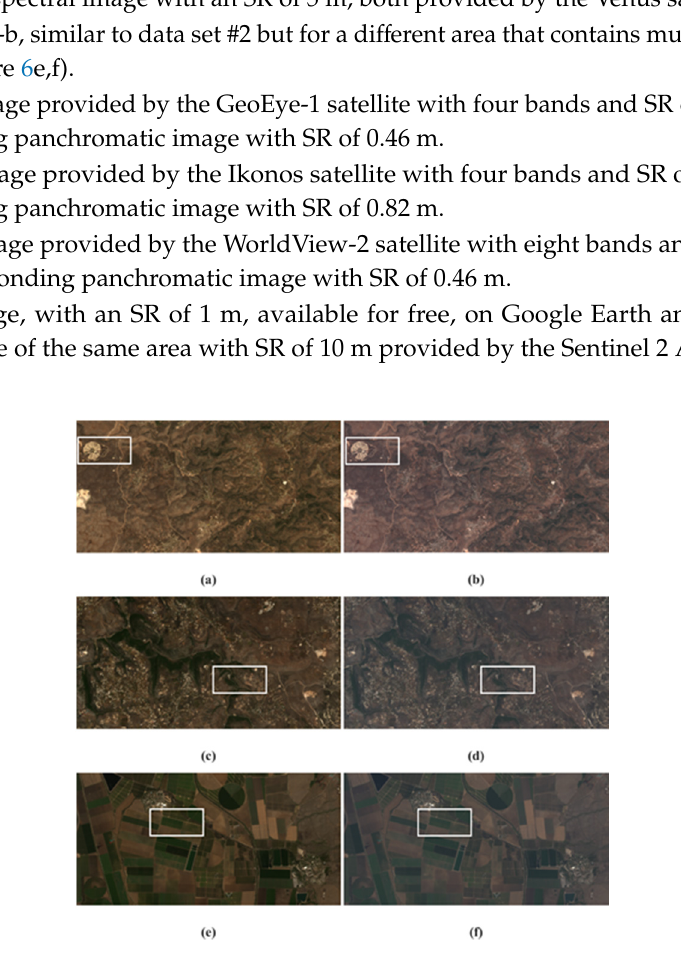
Figure 7. RGB composite of datasets in Group-2 used for the experimental evaluation. ( a ), ( b ) and ( c ) GeoEye-1, Ikonos, and WorldView resampled images with LSR of 7.36 m, 13.12 m, and 7.36 m, respectively. ( d ), ( e ), and ( f ) are the corresponding original images with HSR of 1.84 m, 3.28 m, and 7.36 m, respectively. White rectangles denote areas used for visual analysis. Comparing to the state-of-the-art An alternative to the DFuSIAL for enhancing the SR of the unmixing fraction maps, through data fusion of visible HSR and spectral LSR images, is based on the PS technique. Using PS, we first retrieve an HSR spectral image and then apply the unmixing process to obtain HSR fraction maps. To analyze the performance of the DFuSIAL versus the state-of-the-art, we use two of the recent PS methods: (1) The conventional filter-based approach, presented in [61], is intended for preserving spectral quality (PSQ). For the sake of convenience, we use the term PSQ-PS to refer to this method in the rest of the paper. (2) The novel CNN-based approach, presented in [26], utilizes a target-adaptive fine-tuning step to achieve a further improvement of the results with comparison to its baseline and accurate